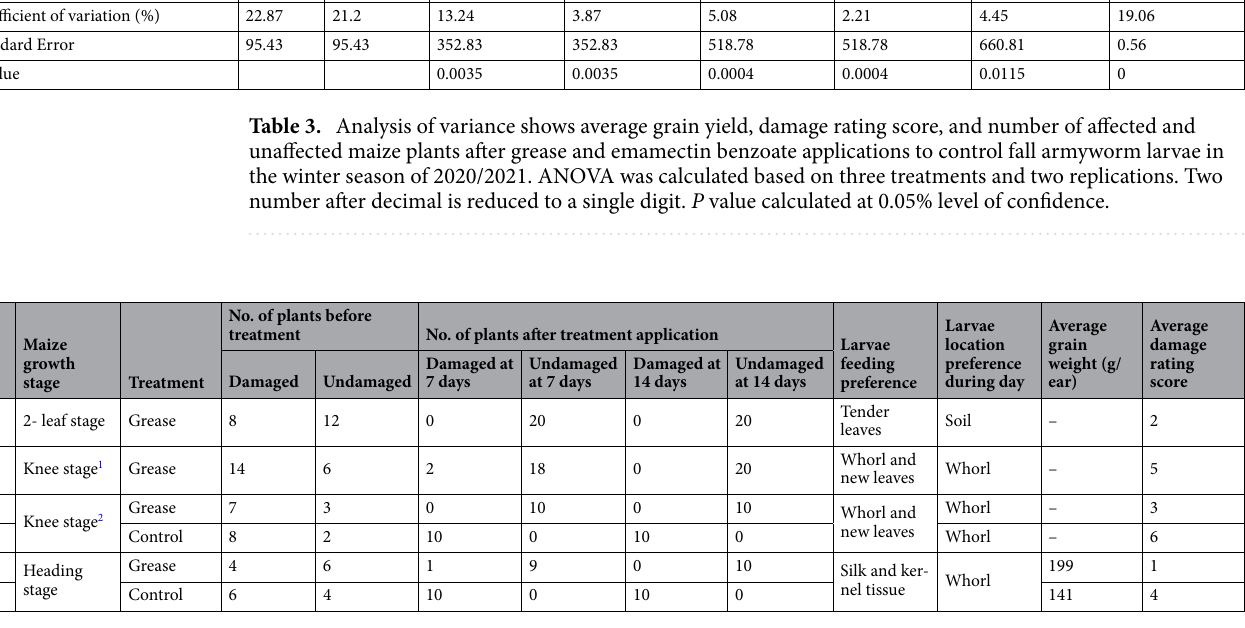
Table 4. Fall armyworm larval damage rating score and feeding preference of potted maize plants in artificial infestation condition,